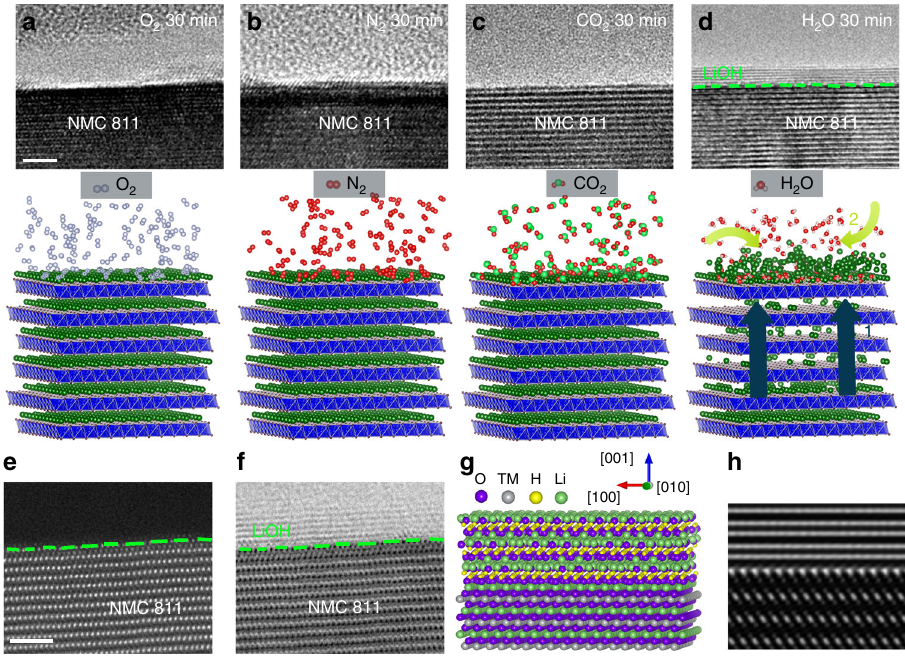
Fig. 1 The chemical delithiation of NMC 811 in air. The green dashed lines outline the surface boundaries of NMC811. a – d The distinct capability of each air component in delithiating the NMC811. The upper panels are the HRTEM images of NMC 811 surface after exposure to N 2 , O 2 , CO 2 , and water vapor at the gas pressure of 5 × 10 − 2 Torr and at the room temperature for 30 mins, respectively. The lower panels show the schematic drawing of Li ions evolution in the layered structure under the exposure of each corresponding gas. The label 1 and 2 in d indicate the typical two steps for the formation of LiOH: the Li diffusion from bulk to surface, followed by the surface reactions. e , f Identi fi cation of surface reaction products by HAADF-STEM and the corresponding ABF-STEM imaging of NMC811 after prolonged exposure in water vapor. g Atomistic model of LiOH on NMC substrate with the alignment of LiOH(001)// NMC(001) and LiOH[230]//NMC[1-10]. h The simulated HRTEM image based on the model in g . Scale bar, 2 nm a , e .